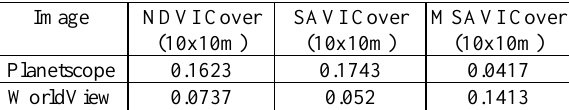
Table 1. R-squared values of field versus vegetation index- derived cover at 10 x10 meter